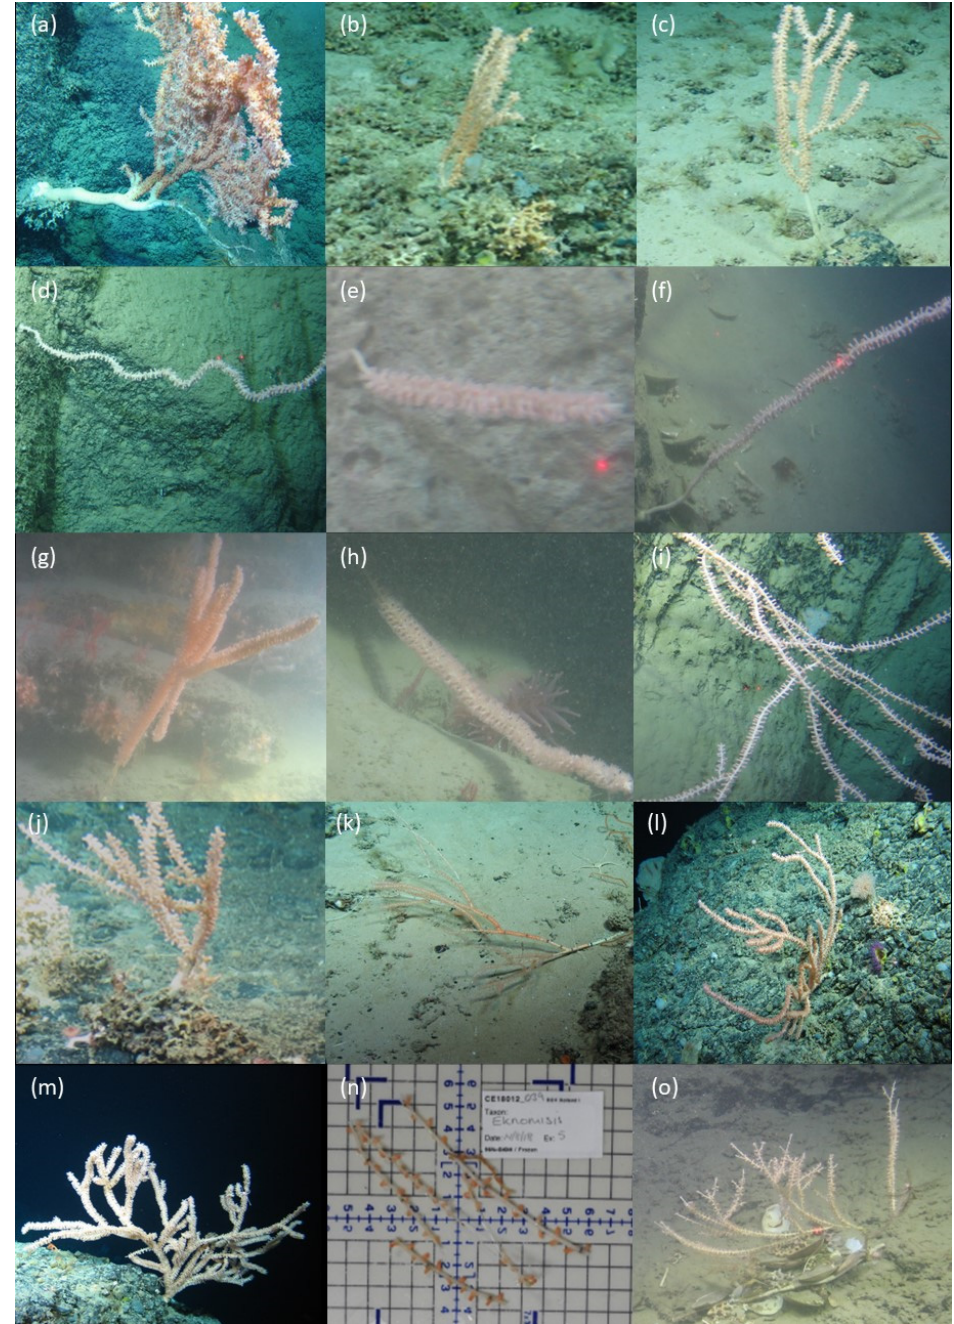
Figure 2. In situ photographs taken by ROV Holland I representing the gross morphology of ( a ) Haplotype 1 (M7), ( b ) Haplotype 1 (M8), ( c ) Haplotype 2 (M9), ( d ) Haplotype 3 (M12), ( e ) Haplotype 4 (M10), ( f ) Haplotype 5 (M13), ( g ) Haplotype 6 (M10), ( h ) Haplotype 6 (M11), ( i ) Haplotype 7 Eknomisis sp. (M4), ( j ) Haplotype 8 Eknomisis sp. (M5), ( k ) Haplotype 8 Eknomisis sp. (M6), ( l ) Haplotype 9 (M1), ( m ) Haplotype 10 (M3), ( n ) Haplotype 11 (M2)(there was no in situ image found of Haplotype 11, instead there is an image taken in the laboratory) and ( o ) Haplotype 12 (M15).